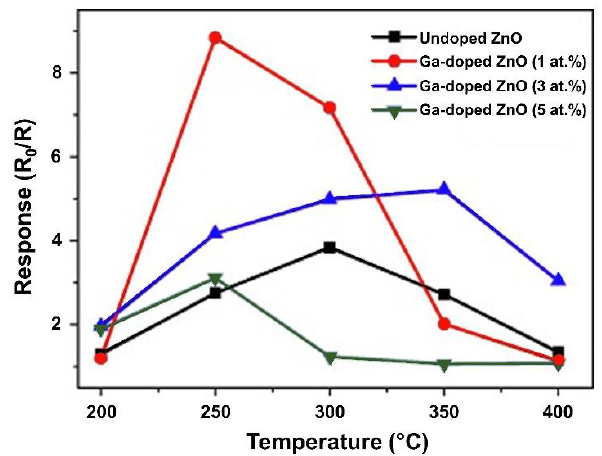
Figure 5. Response to 50 ppm CO of the Ga-doped ZnO nanoparticles as a function of the temperature. Ga concentration of samples correspond at 0, 1, 3 and 5 at. %. Obtained from reference [77].